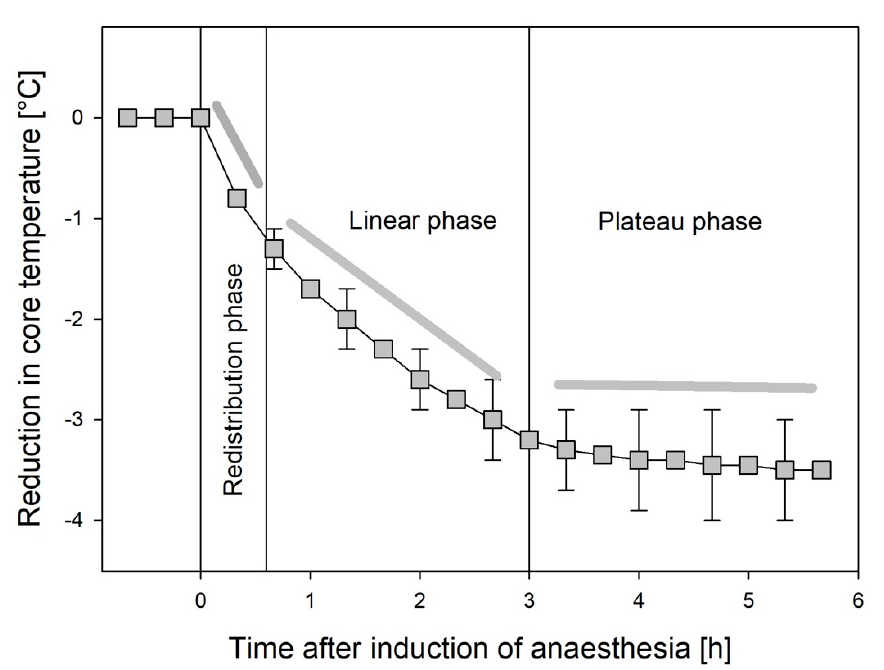
Figure 1. Influence of induction of general anaesthesia on core temperature. The redistribution phase, linear phase, and plateau phase can be seen. The figure shows the mean values and standard deviation (redrawn with modifications from [54]).